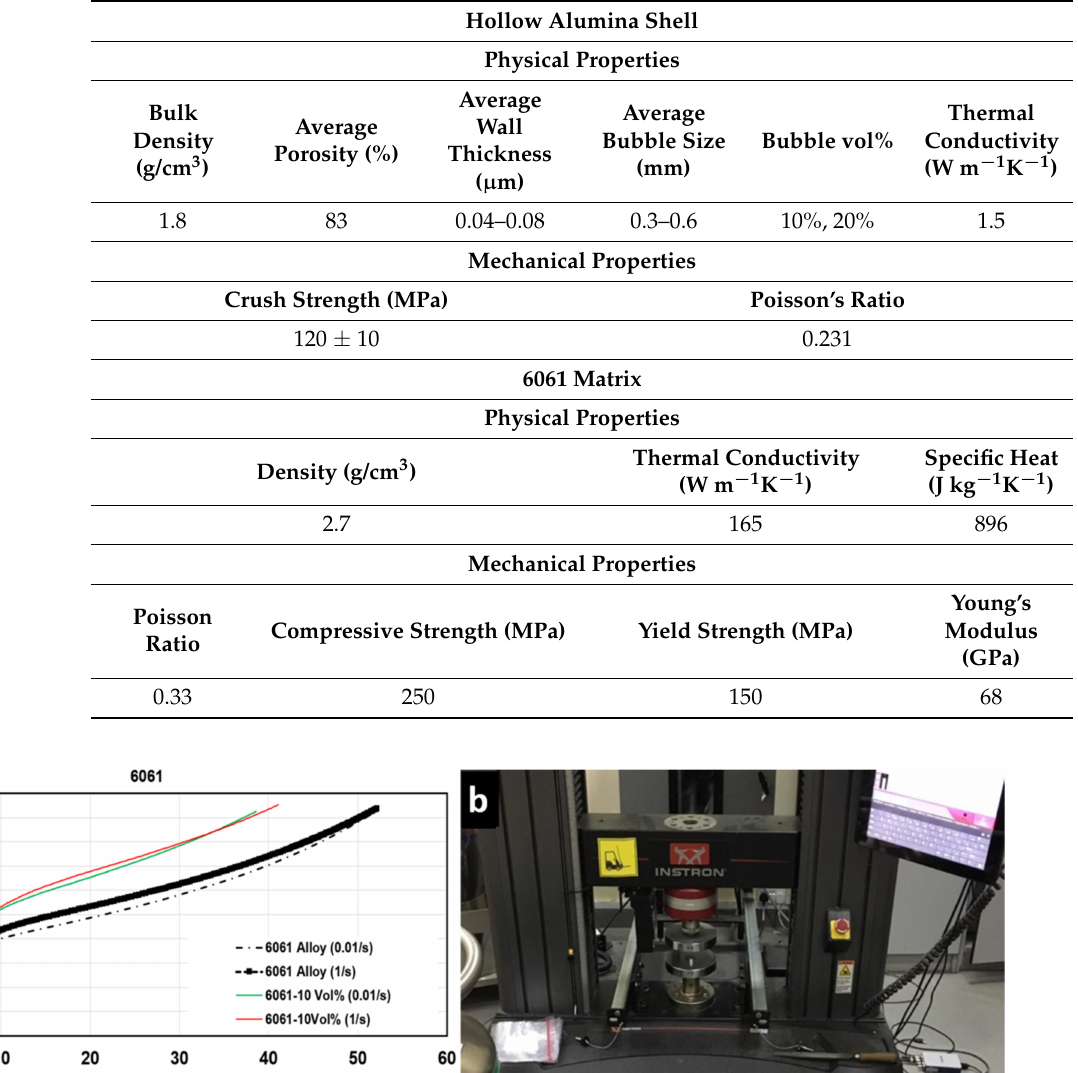
Table 2. Physical and mechanical properties of the hollow alumina shell and 6061 matrix [16–18].